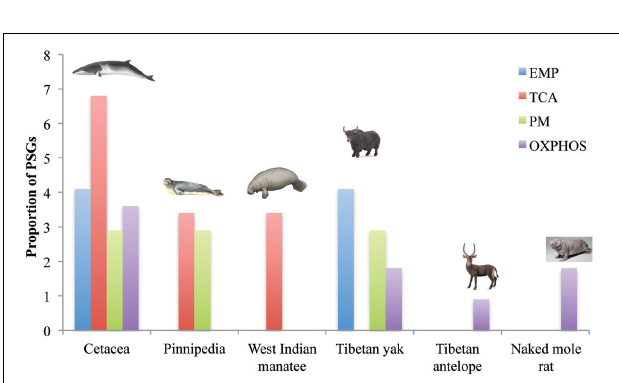
FIGURE 3 | Positively selected genes of four energy metabolism pathways in hypoxia-tolerant mammals. EMP/GNG, TCA, PM, and OXPHOS denote the KEGG Pathway categories Glycolysis/Gluconeogenesis, Citrate cycle (TCA cycle), Pyruvate metabolism, and Oxidative phosphorylation,